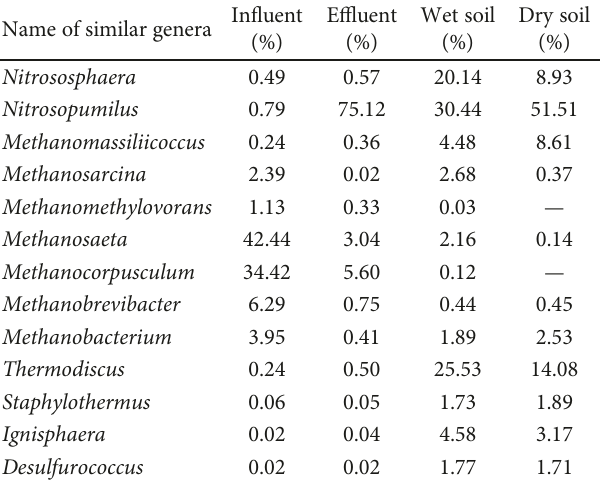
Figure 7: Archaeal relative abundance of four samples in classes in constructed wetlands. Table 5: The archaeal dominant genera in four samples in constructed